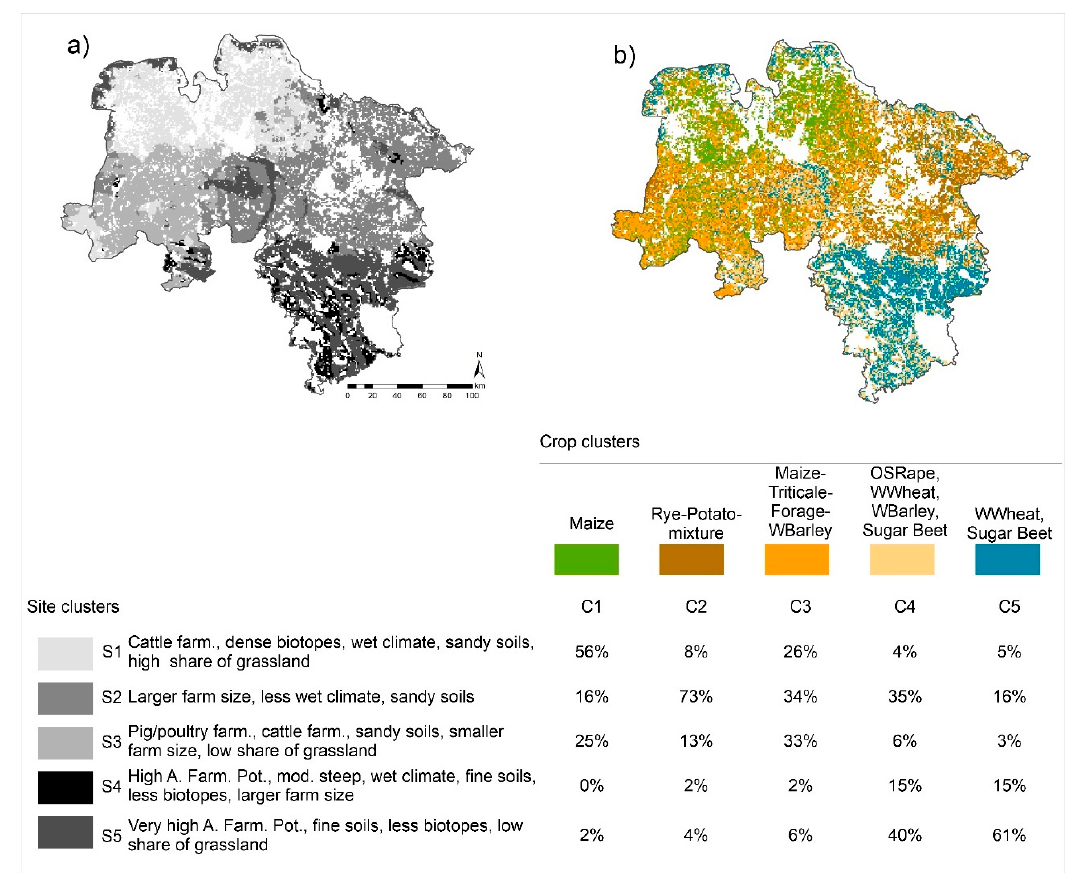
Figure 3. Spatial projection of the statistical k-means clustering results and the proportion of congruent areas in percent: ( a ) site clustering (S1–S5) and description, ( b ) crop clustering (C1–C5). Only quadrants ≥ 10 ha of arable area are included.